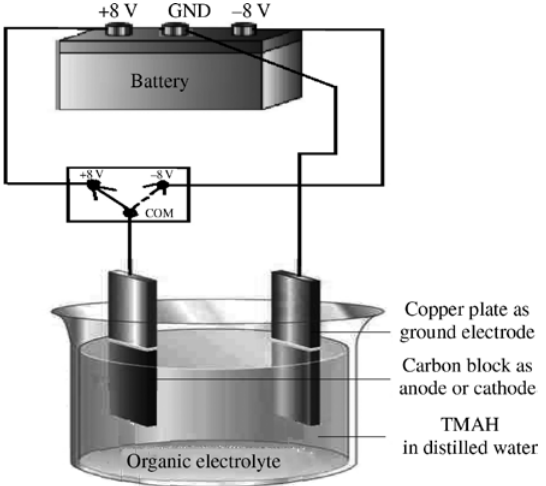
Figure 1: Schematic illustration of the electrochemical exfoliation setup.